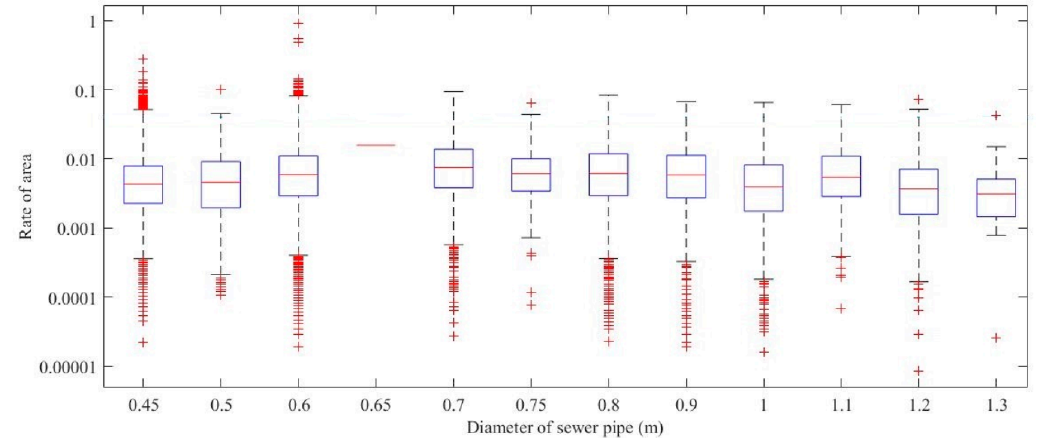
Figure 3. Box plot for the rate of area between the pipe and sewage flow by the diameter.